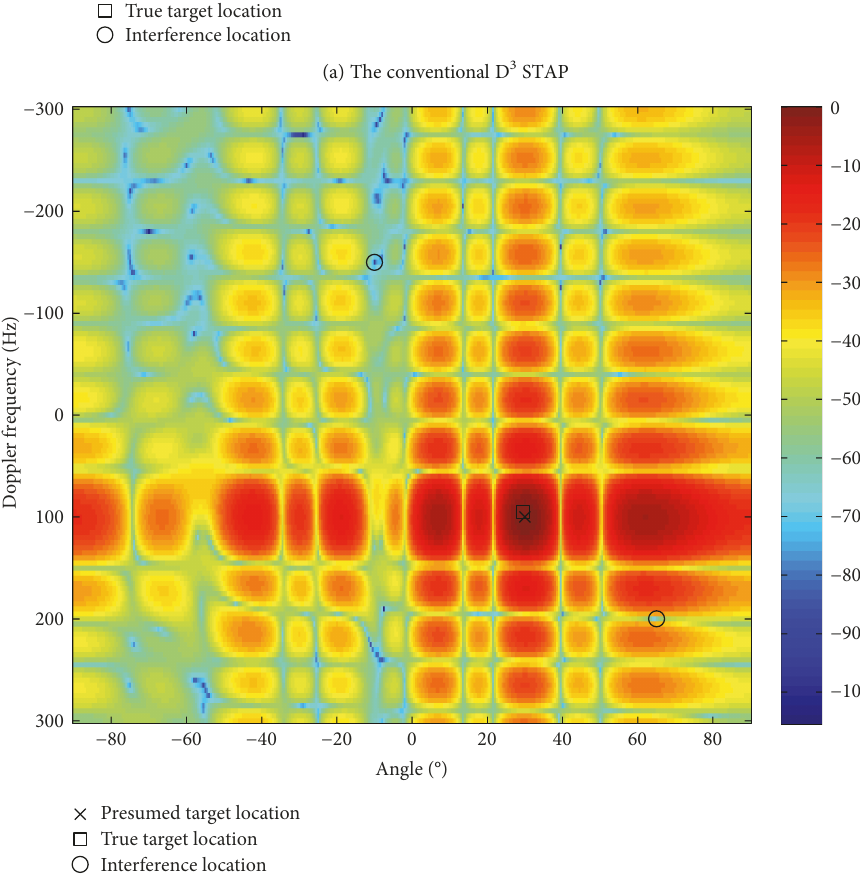
Figure 3: Adaptive weight patterns with signal steering vector